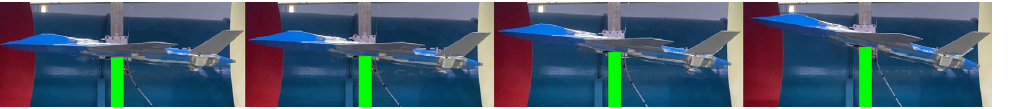
Figure 30. Captures of the test when the model arose at wind speed 24 m/s to the height 110 mm.